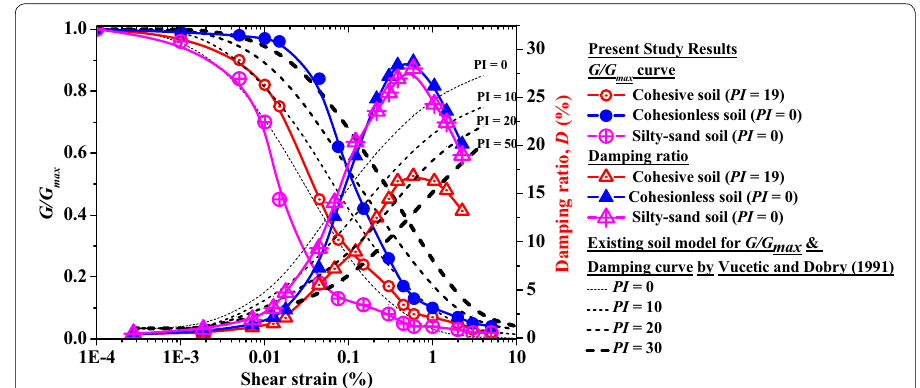
Fig. 16 Comparison of modulus reduction and damping ratio curves for the soils of northeast India as obtained from present site-specific study and from existing standard